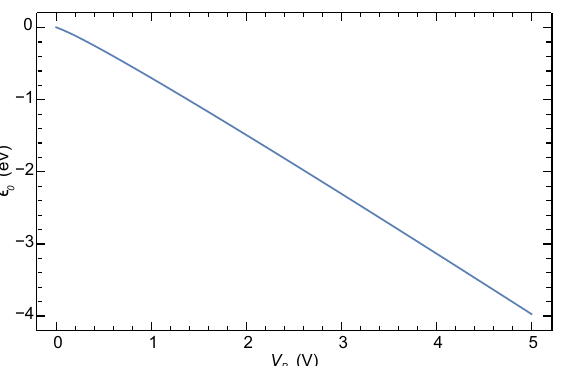
Figure 6. Ground-state energy of model 1 vs. bias voltage. Their relation is almost linear with a slope of about − 4/5.